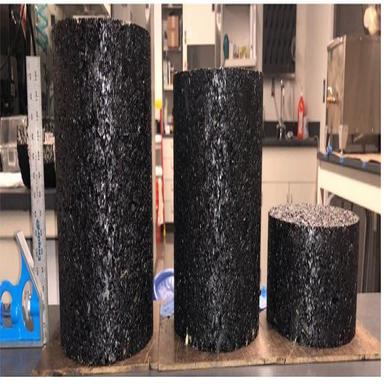
Asphalt mixture gyratory specimens with varied heights.